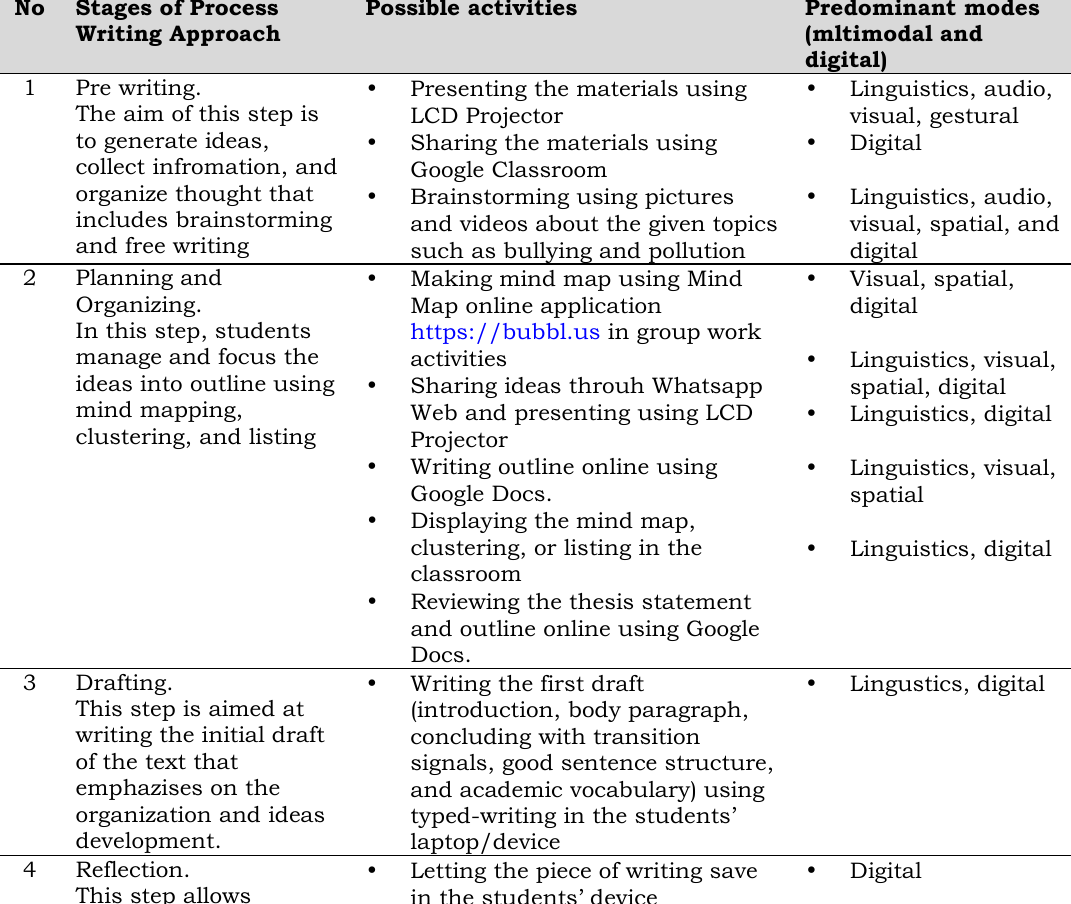
Table 1. Stages and possible activities for multiliteracies and process approach